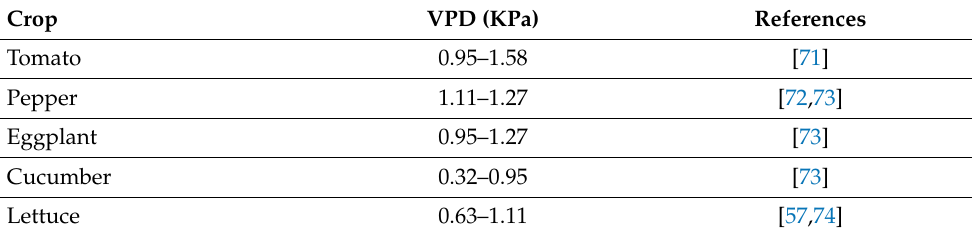
Table 4. PPFD requirement for selected greenhouse crops grown used in arid regions.